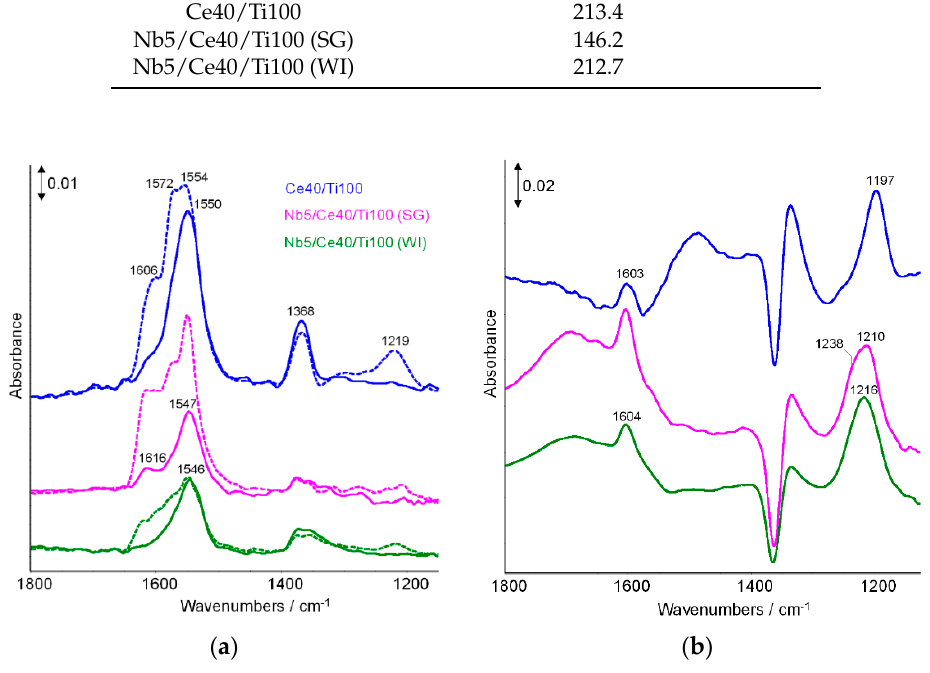
Figure 7. In situ DRIFT spectra of Ce40/Ti100, Nb5/Ce40/Ti100 (SG), and Nb5/Ce40/Ti100 (WI) measured at 200 °C after ( a ) NO/O 2 /He adsorption (dashed lines) and subsequent flushing with He (solid lines) and ( b ) exposure to NH 3 /He and subsequent flushing with He.